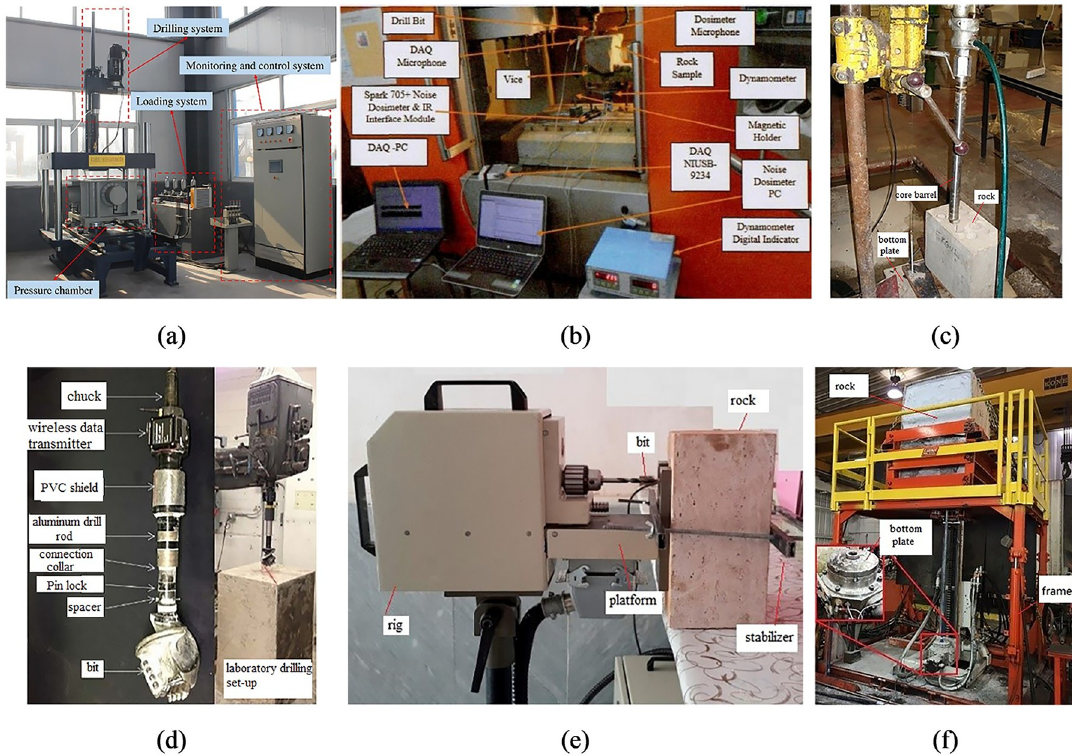
Fig 1. The main MWD devices developed in the